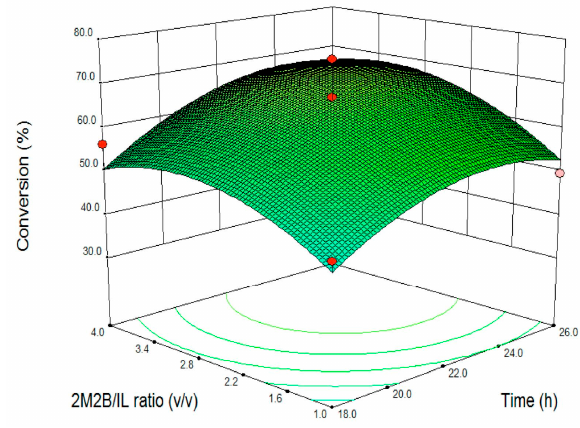
Figure 5. Response surface plot of conversions as a function of the 2M2B/IL volumetric ratio and reaction time (h).